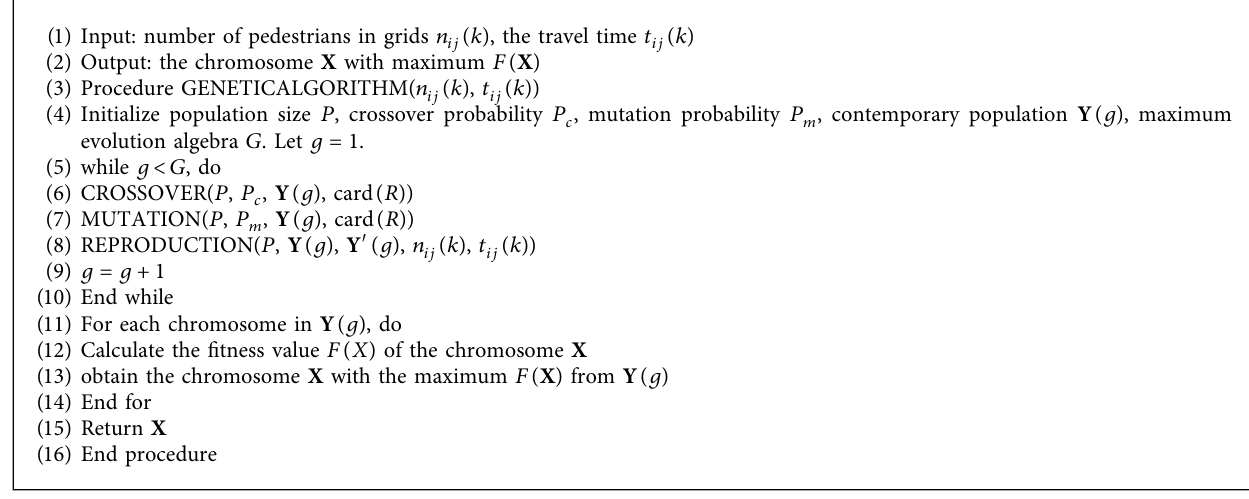
A LGORITHM 1 : Genetic algorithm for upper-level model.